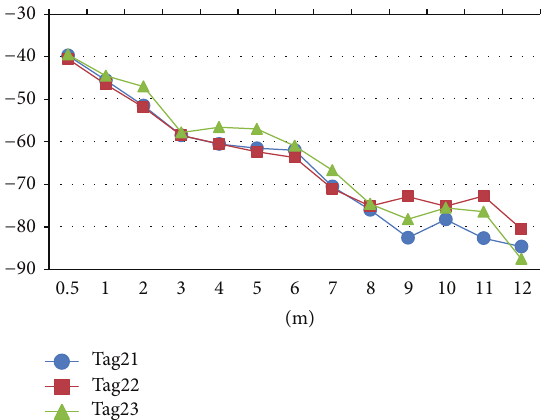
Figure 7: Average value of signal strength sent by three tags and measured within different ranges.